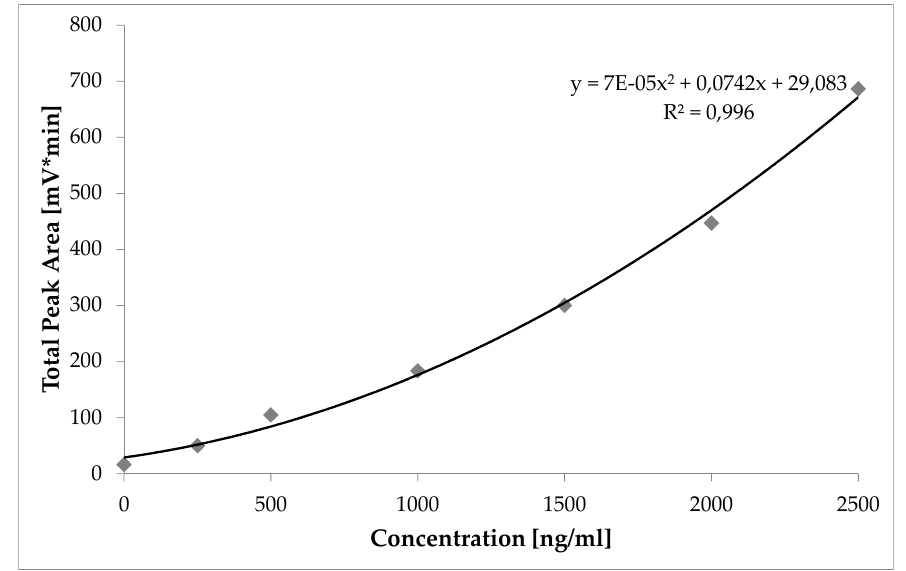
Figure 3. Sum of all MALLS detector angle areas (total area) of the laponite peaks versus the concentration (injection volume 2000 µL).